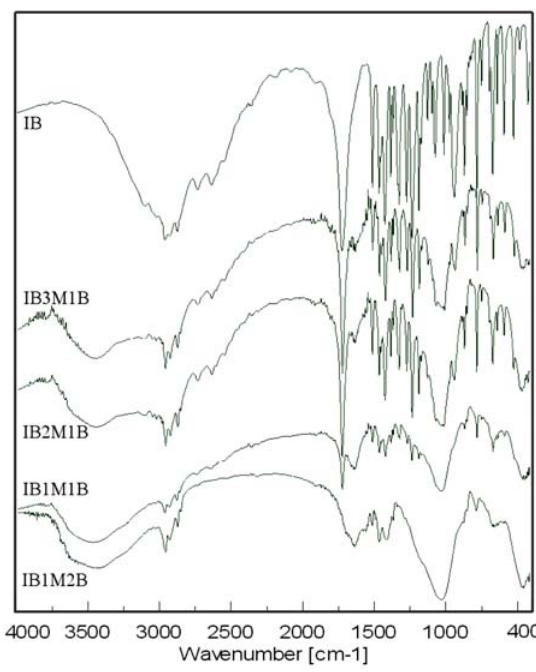
Figure 1. (contd.) Figure 1. FTIR spectroscopy of co-processed ibuprofen and magnesium trisilicate after dry-state ball-milling (a) MTS, IB, IB3M1F, IB2M1F, IB1M1F, and IB1M2F; and aqueous state equilibration and freeze-drying (b) IB, IB3M1B, IB2M1B, IB1M1B, and IB1M2B (abbreviations are explained in Table